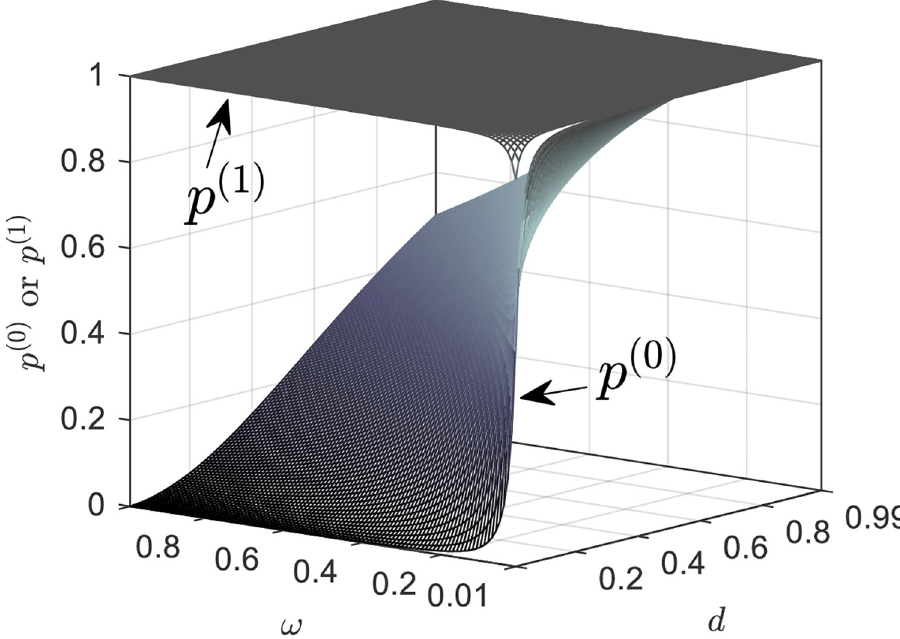
Fig 5. The critical points p (0) and p (1) as functions of ω and d , when μ = 0.01.